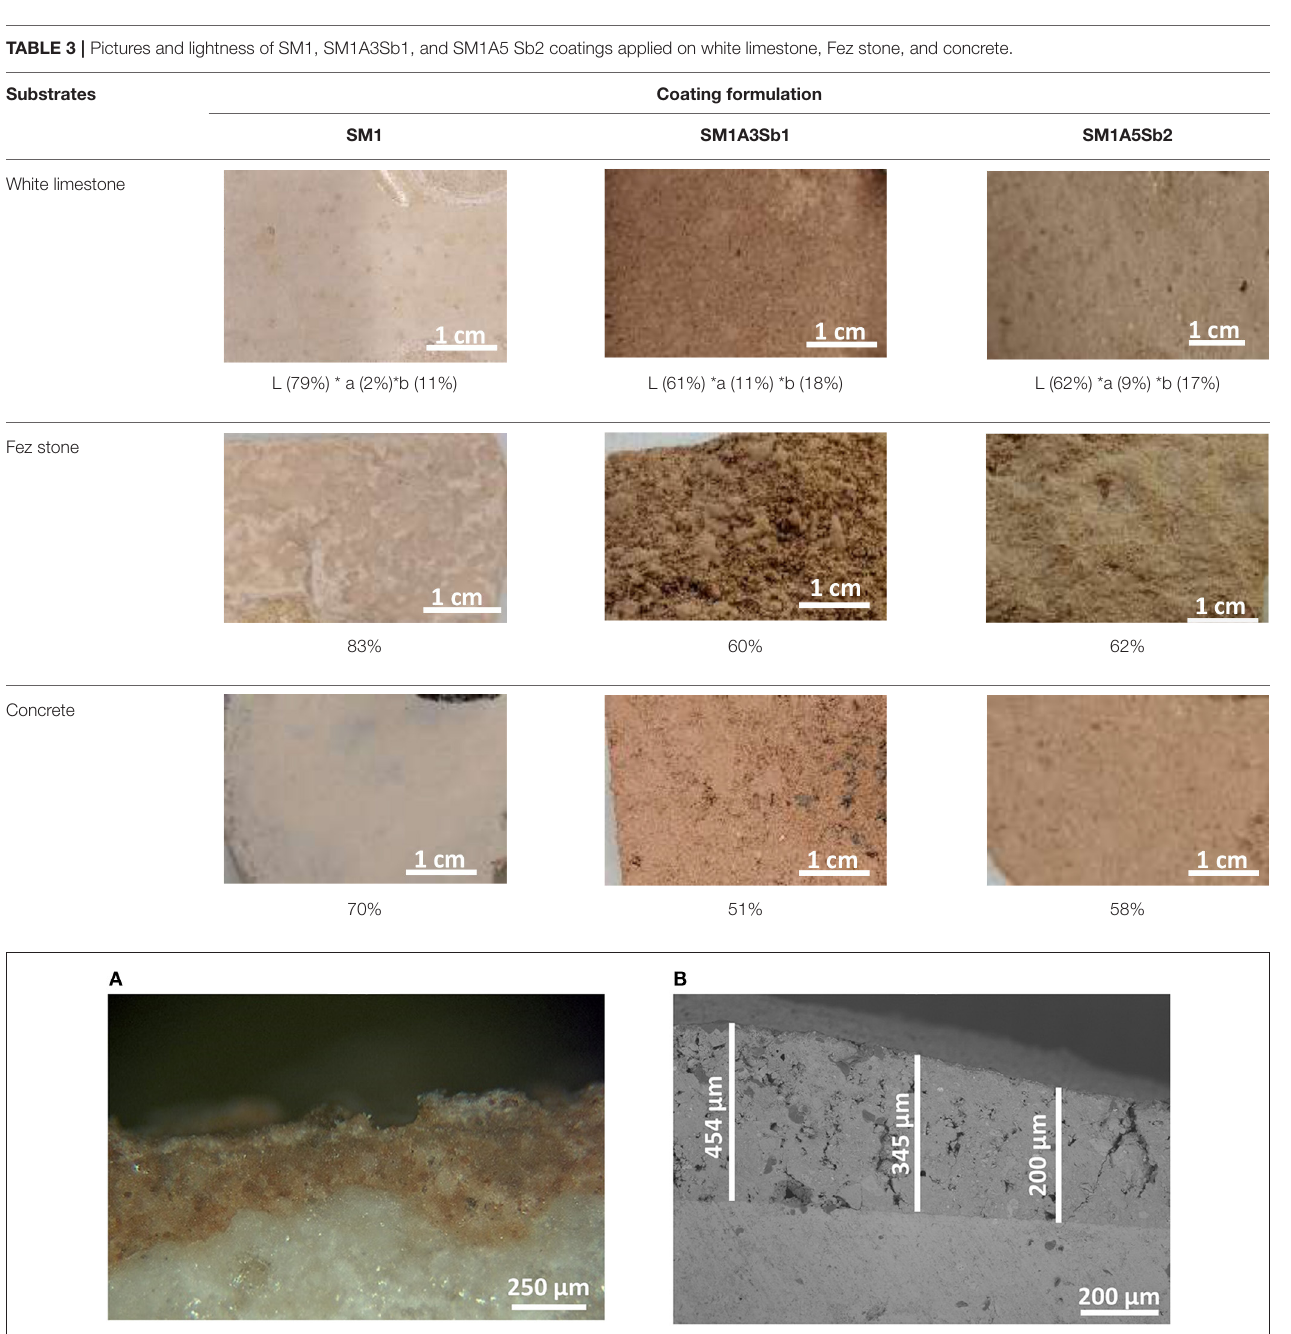
FIGURE 3 | Optical microscope image of S1A5M1Sb2 on white limestone stored at T = 20 ◦ C and RH = 50%, (A) observed with optical microscope, and (B) with SEM.